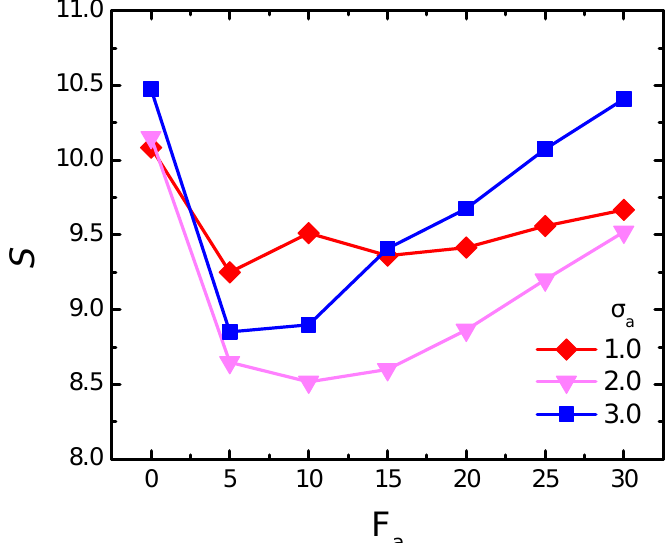
Figure 6. Shape parameter S of the semi-flexible chain as a function of active force F a , for three different crowder sizes, given φ = 0.1 and κ = 1.0.